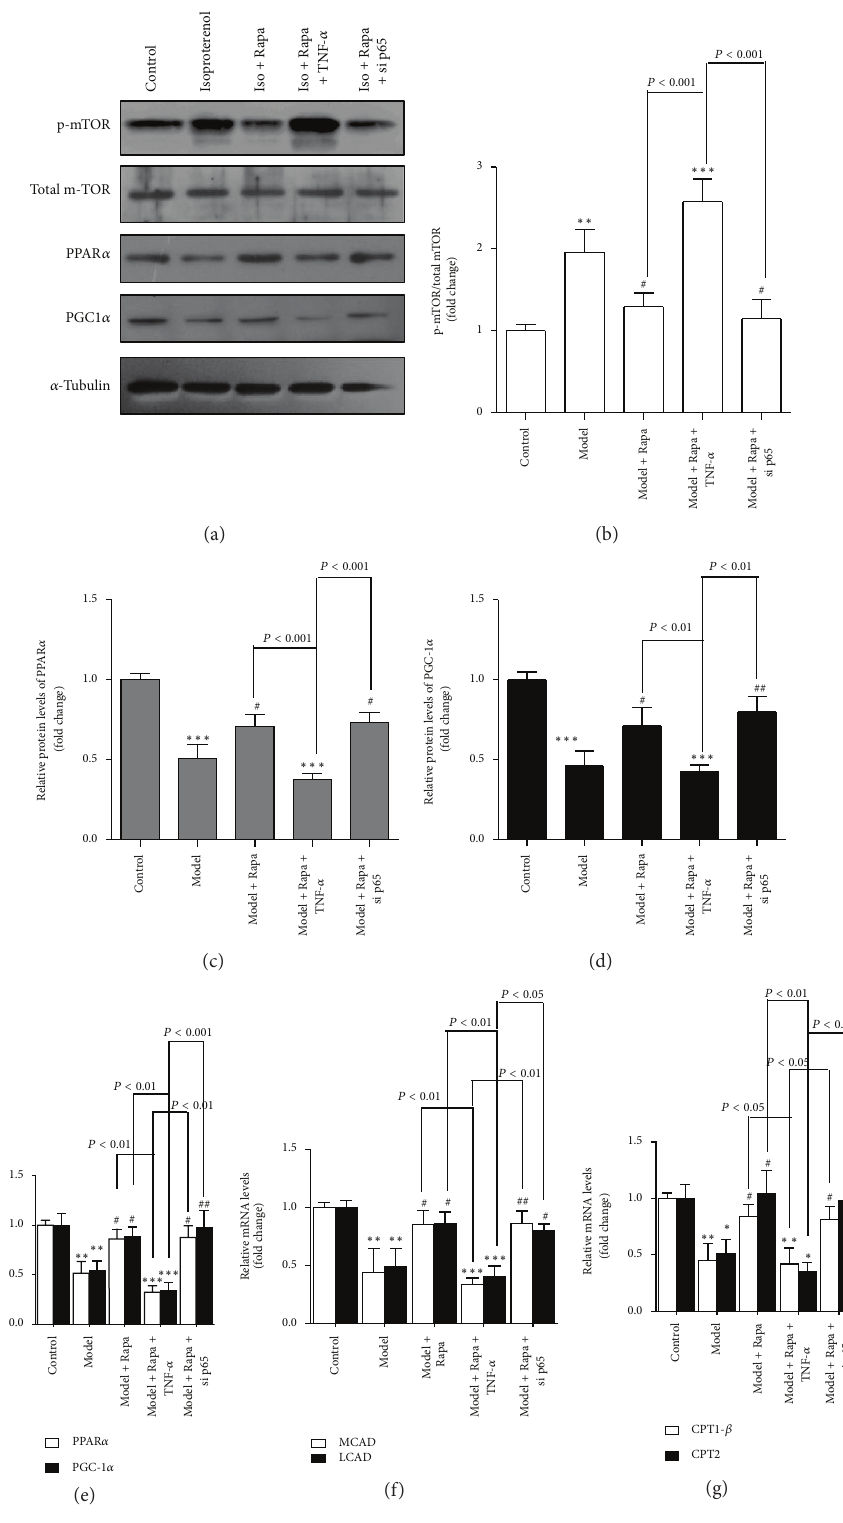
Figure 5: NF- 𝜅 B participates in the role of Rapa in upregulating fatty acid metabolism in cardiomyocytes induced by isoproterenol. (a) Cytoplasmic proteins extracted from cardiomyocytes were immunoblotted with anti-p-mTOR, mTOR, PPAR 𝛼 , and PGC-1 𝛼 antibodies. ((b), (c), and (d)) Densitometric analysis of the relative protein expression of the ratio of p-mTOR/mTOR, PPAR 𝛼 , and PGC-1 𝛼 . And 𝛼 -tubulin was used to normalize proteins loading. ((d), (e), and (f)) Expression of metabolic genes associated with fatty acid metabolism (PPAR 𝛼 , PGC1 𝛼 , MCAD, LCAD, CPT-1 𝛽 , and CPT-2) at mRNA levels. The mRNA was prepared and normalized to 𝛽 -actin gene. 𝑛 = 3 experiments in duplicate. Error bars, SD. ∗ 𝑃 < 0.05 versus control group; ∗∗ 𝑃 < 0.01 versus control group; ∗ 𝑃 < 0.001 versus control group; # 𝑃 < 0.05 versus model group; and # 𝑃 < 0.01 versus model